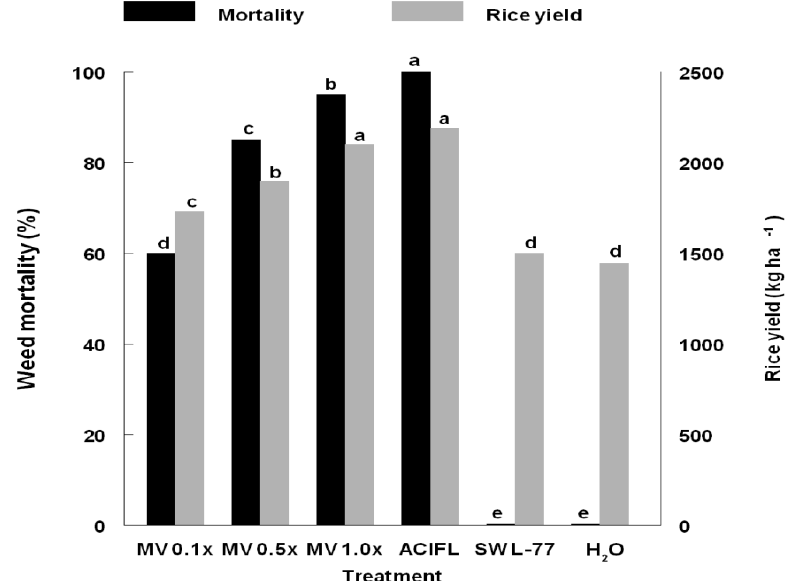
Figure 6. The effects of biological control of hemp sesbania with Myrothecium verrucaria on rice yields, Stoneville, MS. Hemp sesbania mortality data was adapted from Figure 3A for direct data comparison. Yield data were taken (end of season) from plots containing hemp sesbania plants averaging 10–20 cm in height at time of treatment. Histogram bar values for each parameter with the same letter are not significantly different at p = 0.05 using Fisher’s least significant